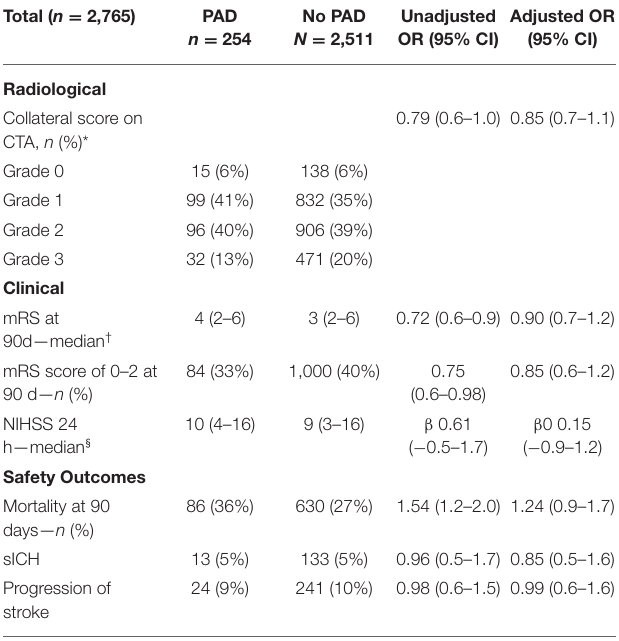
No PAD Unadjusted Adjusted OR n = 254 N = 2,511 OR (95% CI) (95% CI)